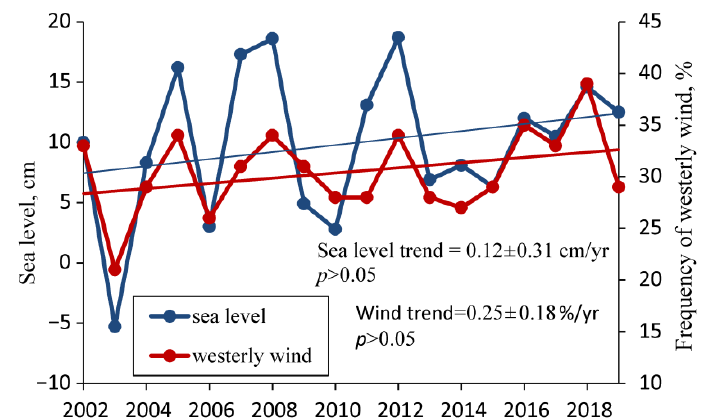
Figure 3. Sea level changes between 2002 and 2019 and their linear